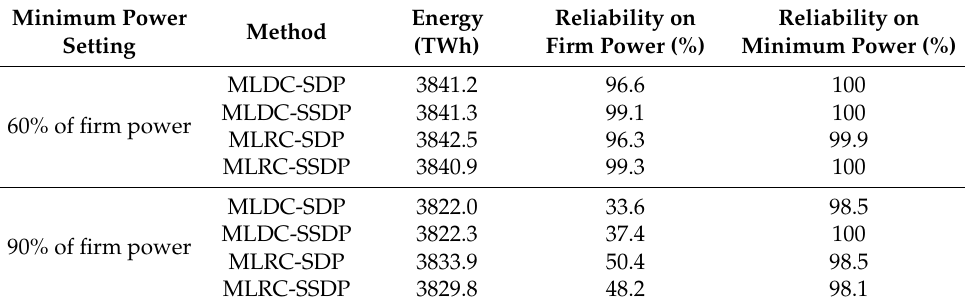
Table 3. Computing results for the cascaded